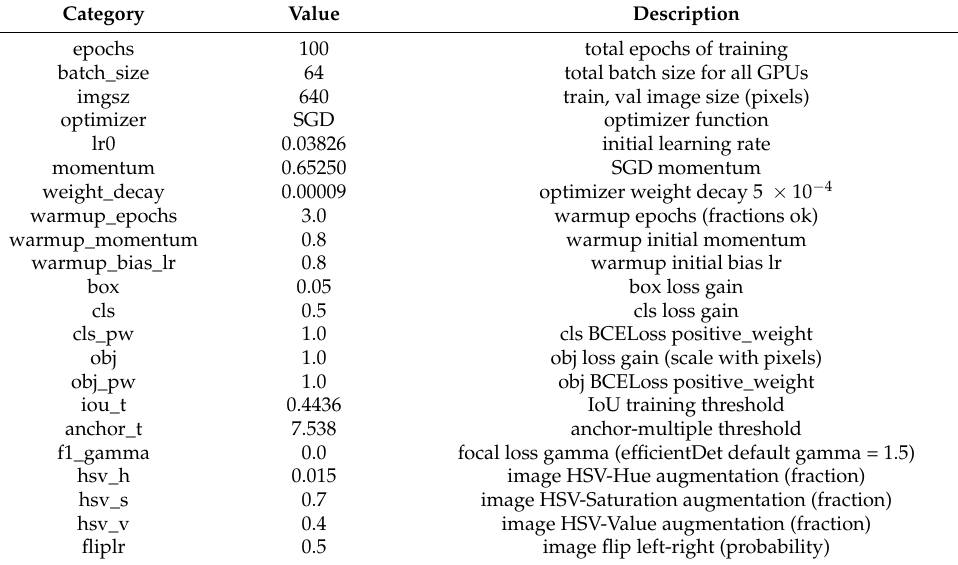
Table 2. The training was performed on one NVIDIA GPU Tesla T4-16GB. Table 2. Optimized model configuration